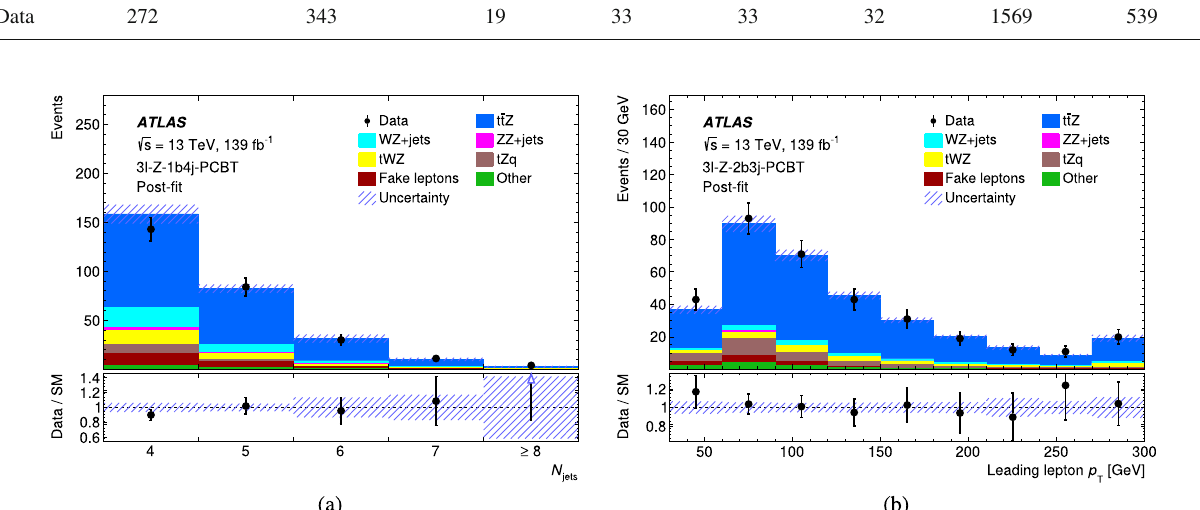
Fig. 4 Post-fit distributions of a N jets in 3 (cid:11) - Z -1 b 4 j -PCBT and b the p T of the leading lepton in 3 (cid:11) - Z -2 b 3 j -PCBT. The shaded band includes all sources of statistical and systematic uncertainty after the combinedfit.ThelowerpanelshowstheratioofdatatothetotalSMpre-